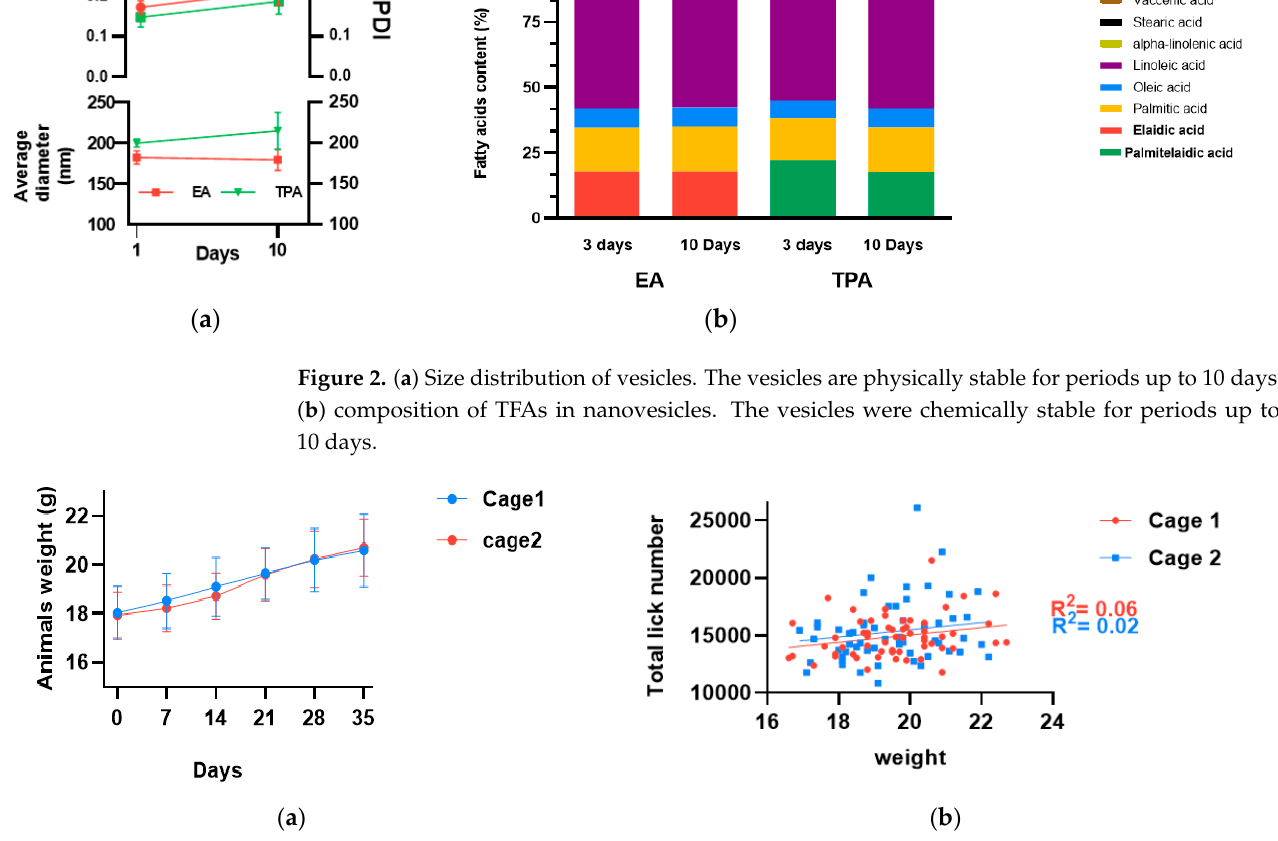
Figure 3. ( a ) Change in weight of animals during the study. Data represent means ± SD. After 5 weeks, animals gained 2.65 g in both experiments ( p -value < 0.05); ( b ) number of licks normalized for the body weight of individuals; linear regression analysis shows no relation between weight and total number of the licks.